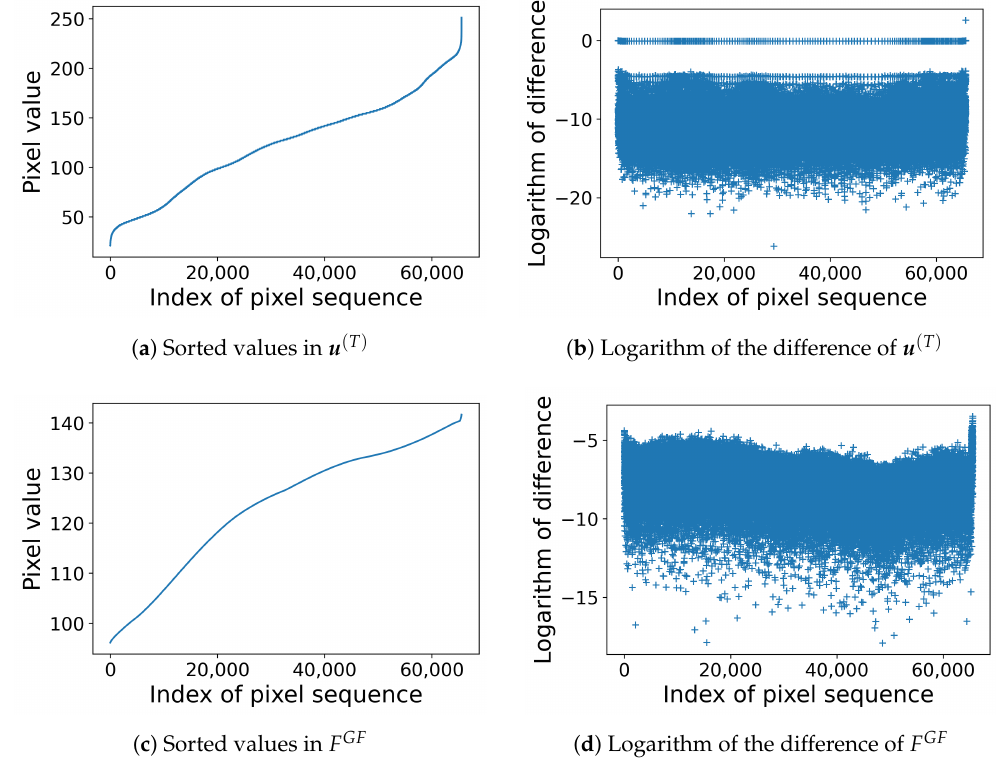
Figure 10. Comparison of filter outputs u ( T ) and F GF : ( a ) The values in the output u ( T ) in Algorithm 1 visualized in Figure 4a are sorted in ascending order. ( b ) The values of log ( u for ι = 1,2, . . . , mn − 1 are plotted. ( c ) The values of the output of the Gaussian filter in (10) with σ = 50 are sorted in ascending order. ( d ) The logarithm of the difference of the sorted values in ( c ) are